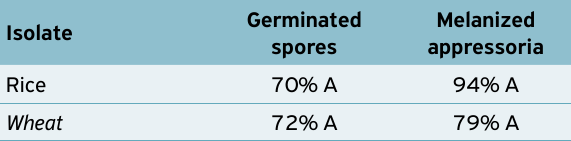
Table 2. Average percentages of germinated spores and melanized appressoria of Magnaporthe oryzae 48 hours after inoculation in wheat and Digitaria plants, 2015 (Aquidauana, Mato Grosso do Sul, Brazil).